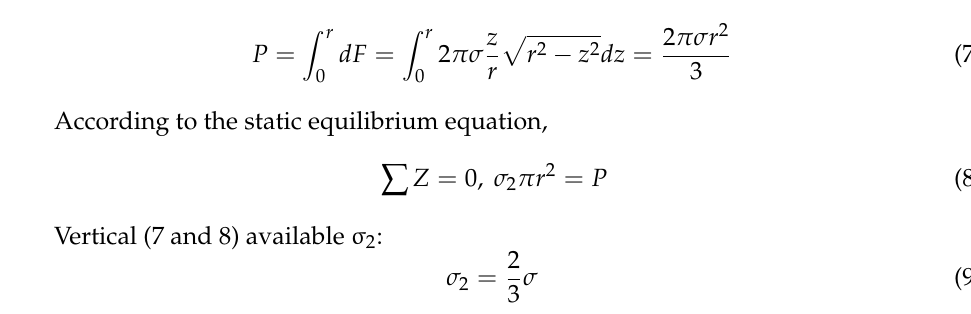
Figure 17. Mechanical calculation model of the hydration products in a microscopic space unit. (a) Schematic illustration of the spatial stress of hydration products. ( b ) Stress profile of hydration.